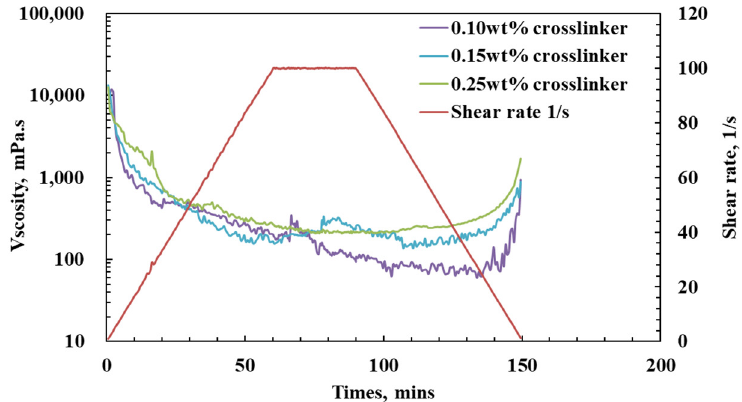
Figure 7. Shear resistance of 0.5 wt % HR9806 at different P/C.